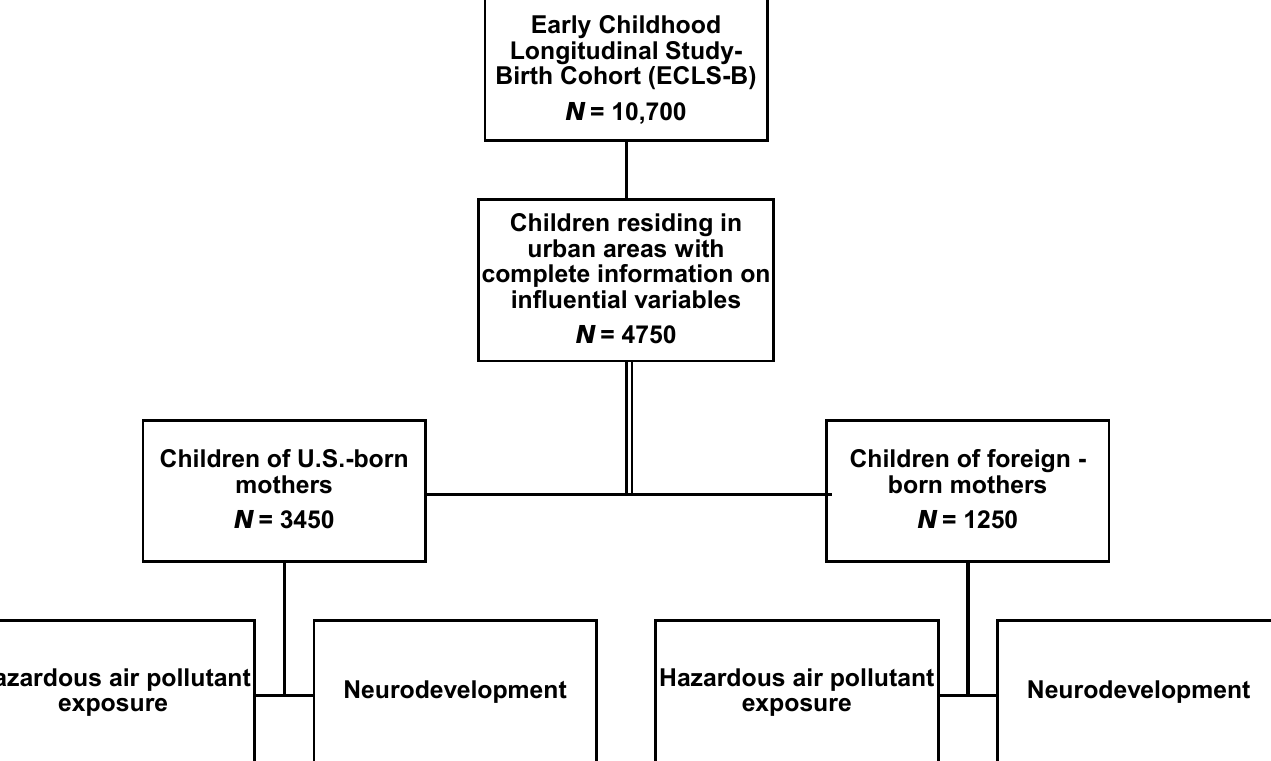
Figure 1. Flow-diagram illustrating the selection of study population from the ECLS-B (2001 birth cohort). All sample sizes are rounded to the nearest 50 per data requirements of NCES.